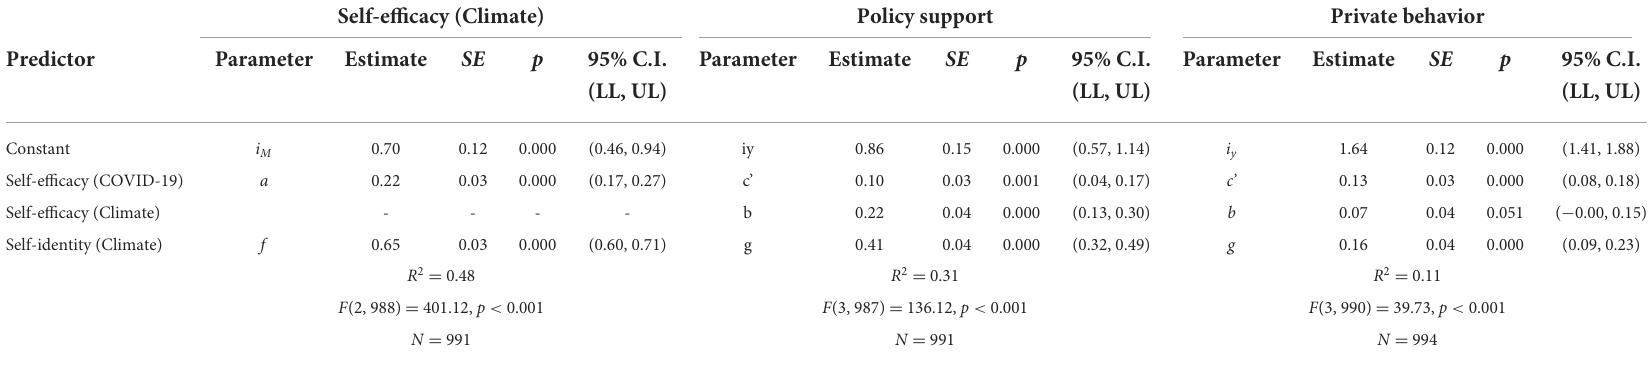
TABLE 1 Model coefficients for the mediation model assuming an indirect effect of COVID-19-related self-efficacy on behavioral responses via climate-related self-efficacy, with self-identity as covariate.